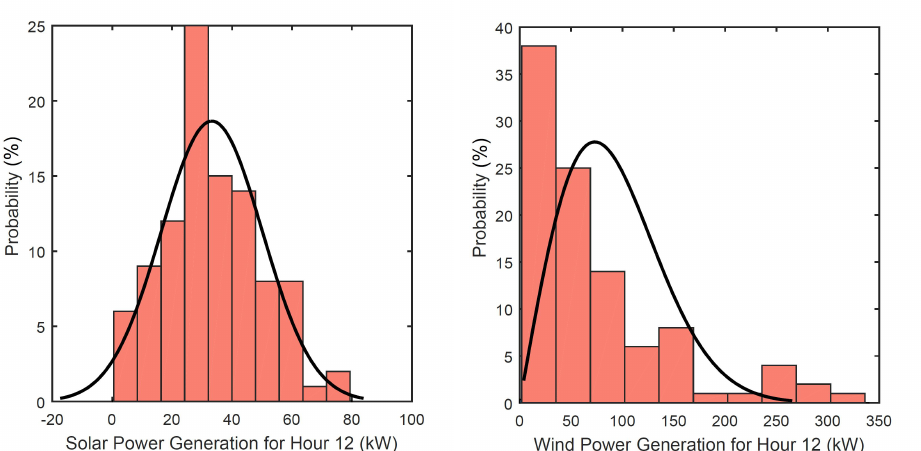
Figure 14. Probability of the power generation from solar PV ( left ) and wind ( right ) at the 12th hour on the 21 June case study.